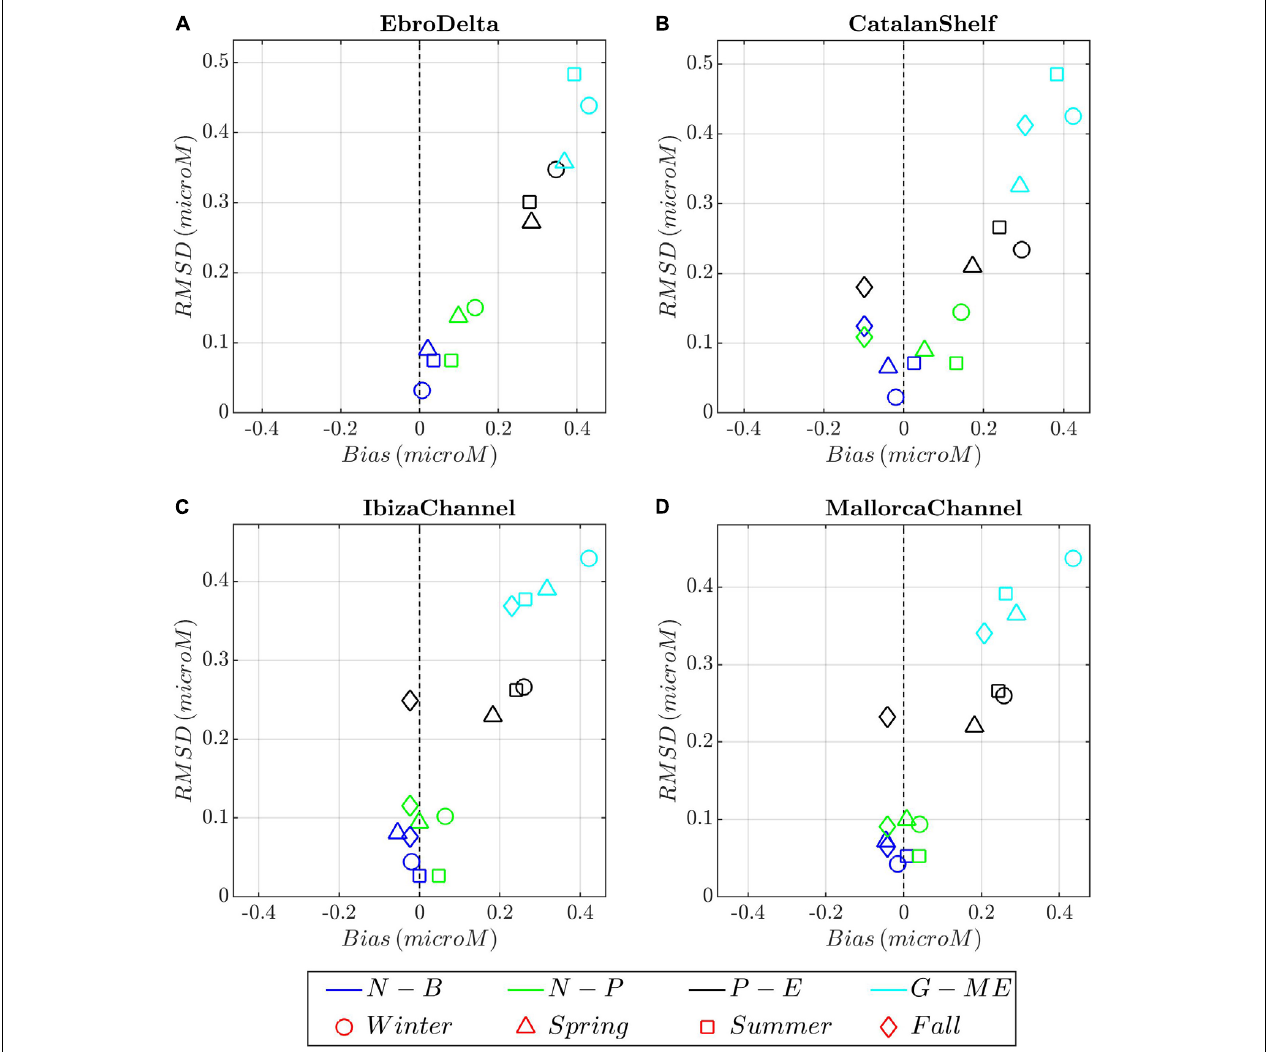
FIGURE 11 | Target diagrams between model runs (color shading) and phosphate climatological profiles for the different seasons (symbols) and areas. (A) Ebro Delta; (B) Catalan Shelf, (C) Ibiza Channel; and (D) Mallorca Channel. Model runs: blue, N-B (NEMO-BFM); green, N-P (NEMO-PISCES), dark gray; P-E (POLCOMS-ERSEM), and light blue, G-E